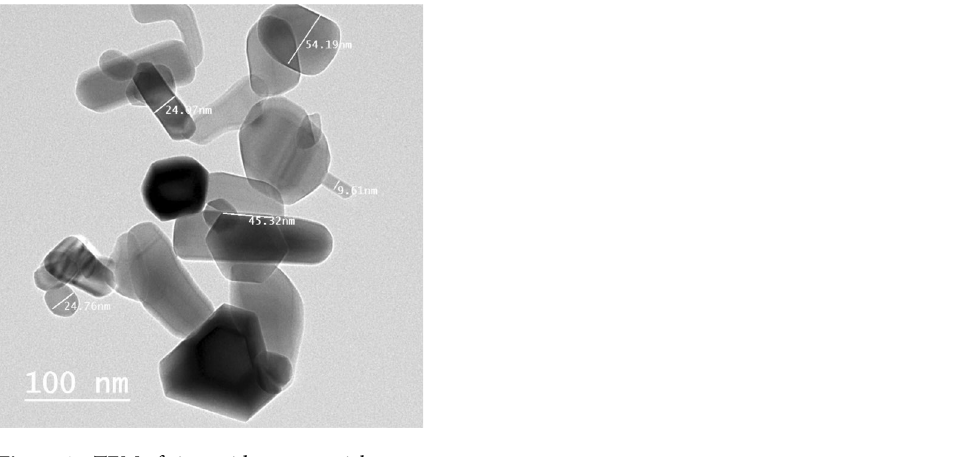
Figure 1. TEM of zinc oxide